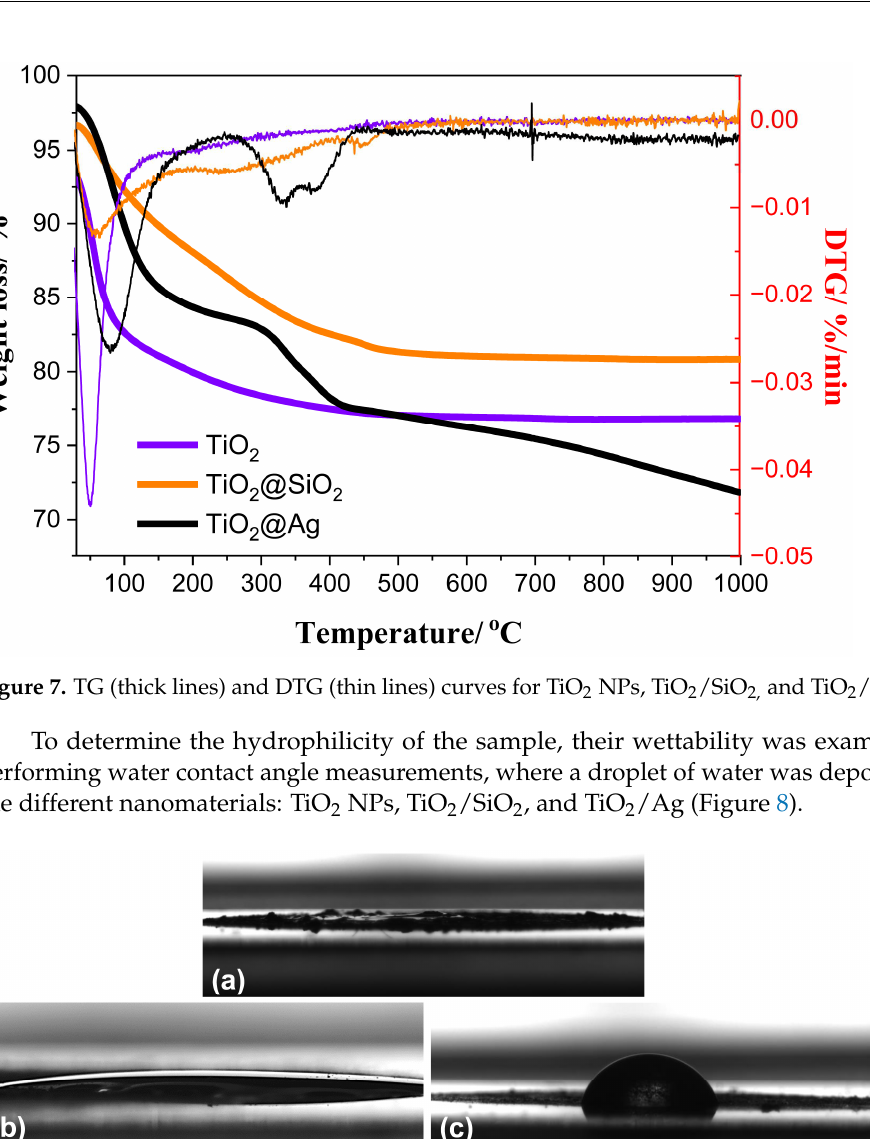
Figure 8. Water contact angle measurement results for ( a ) TiO 2 NPs, ( b ) TiO 2 /SiO 2 , and ( c ) TiO 2 /Ag.